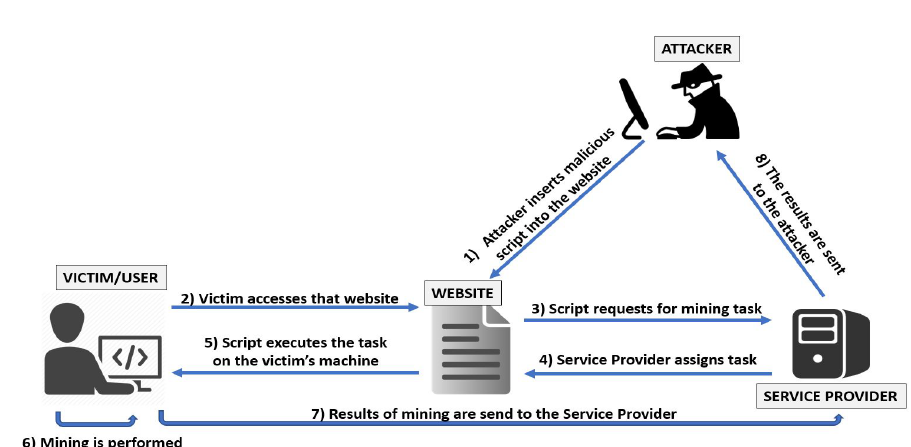
Figure 1. Lifecycle of In-browser